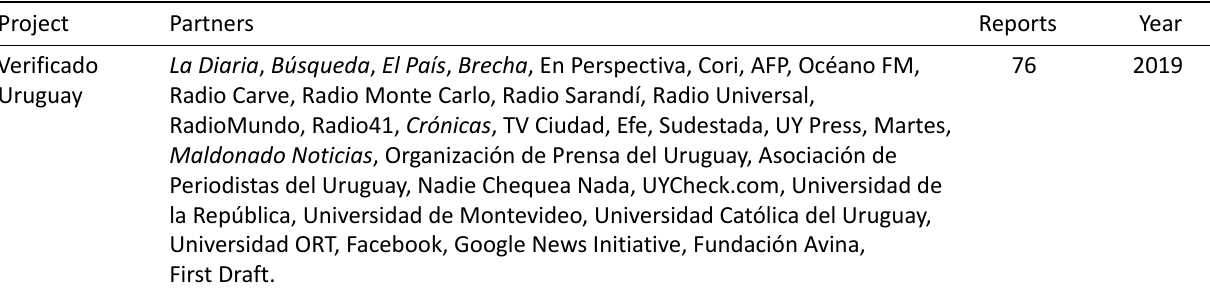
Table 1. (Cont.) List of First Draft election cross-checking